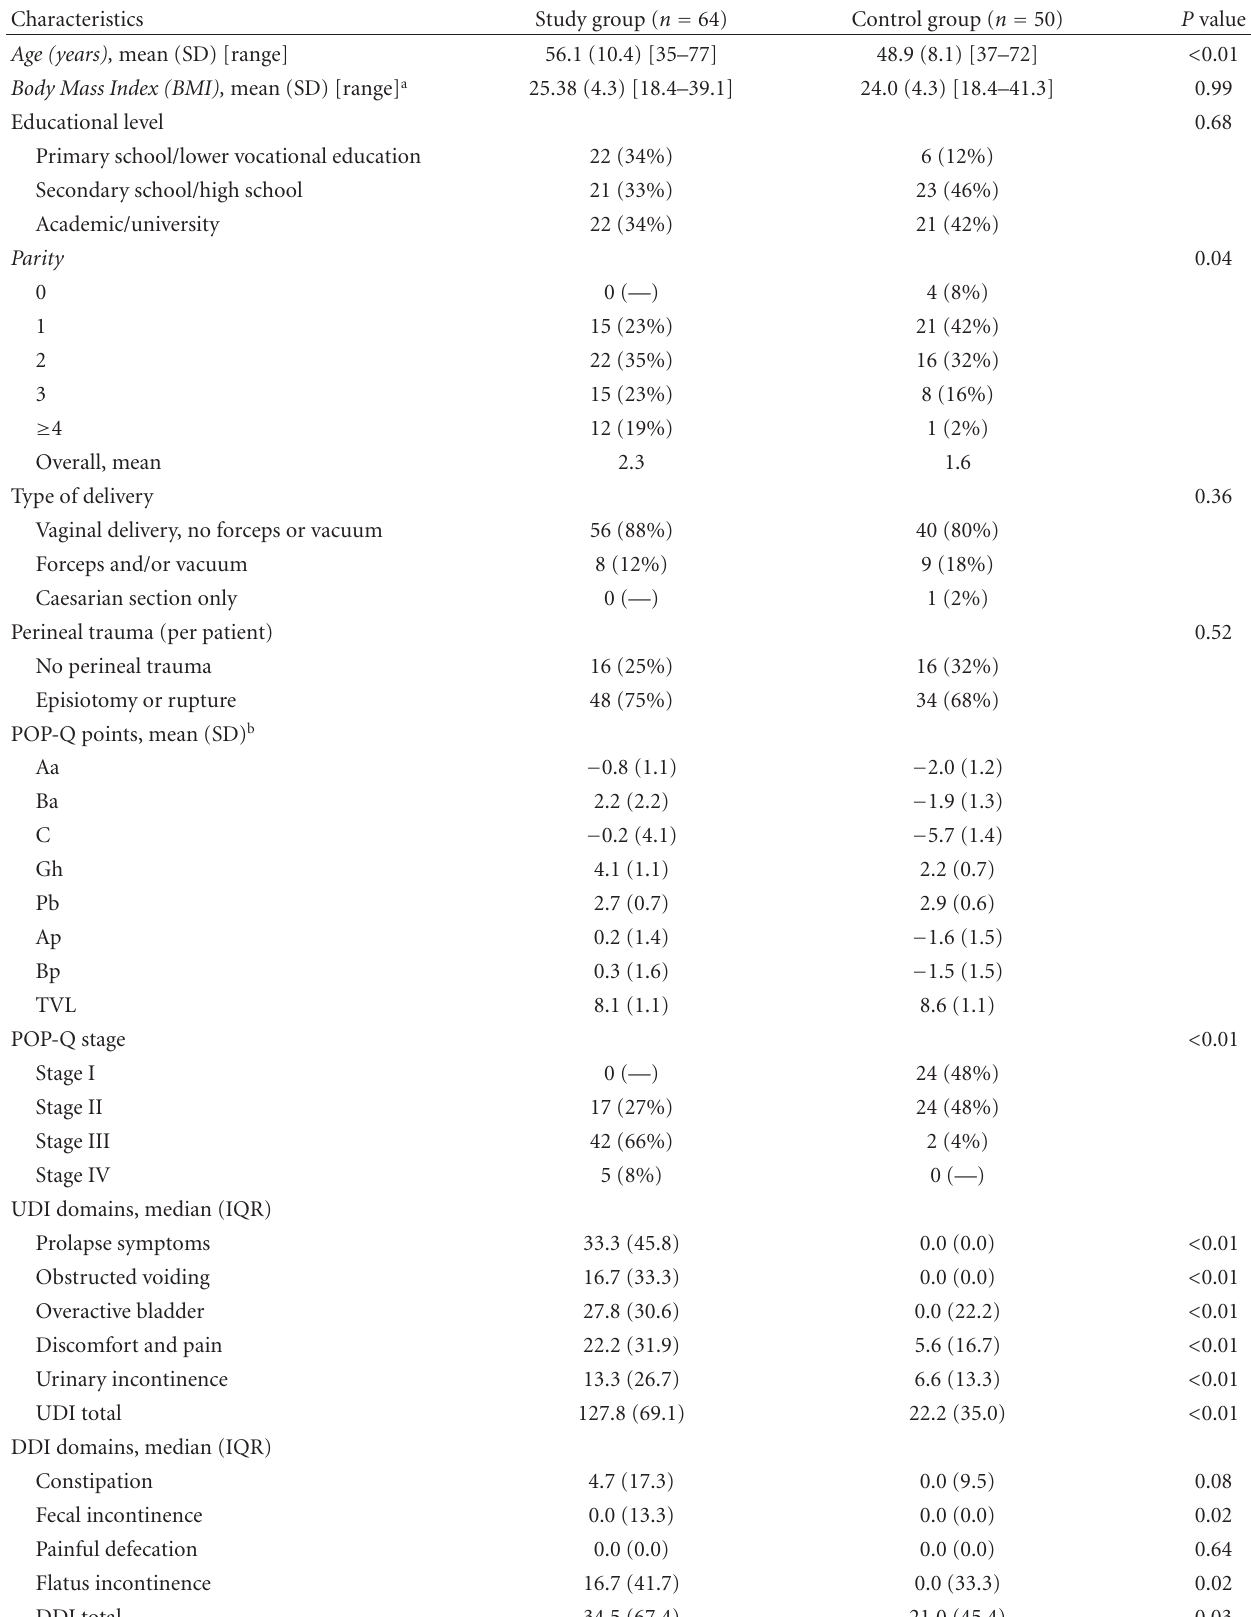
Table 1: Patient’s